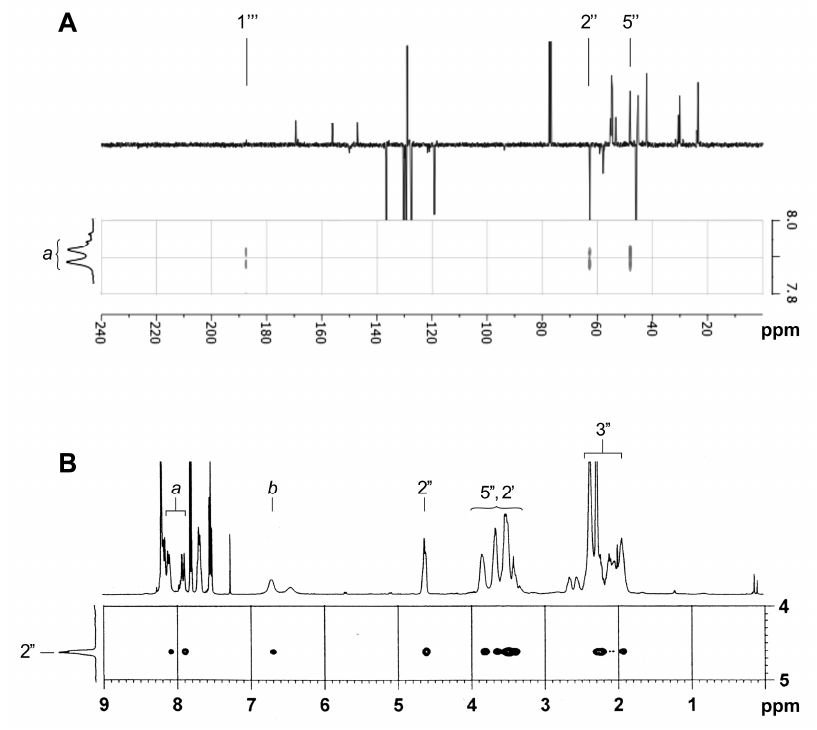
Figure 4. Partial HMBC ( A ) and NOE spectroscopy (NOESY) ( B ) results supporting the structure of β -enaminone 8a .